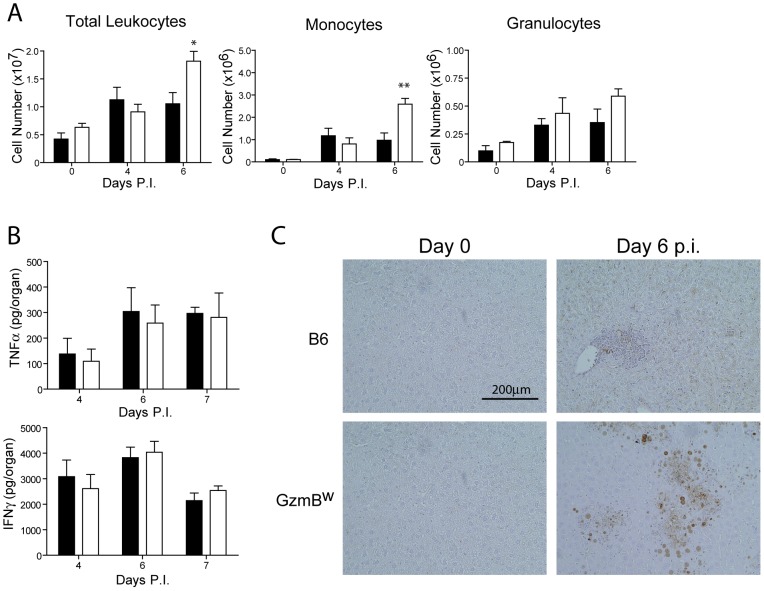
Liver damage in GzmBW/W mice is not the result of immune-mediated pathology.(A) B6 mice (black bar) or GzmBW/W mice (white bar) were infected with Δm157 MCMV and total liver leukocytes, inflammatory monocytes, and granulocytes enumerated at the indicated times. Data are pooled from 2 independent experiments, mean ± SEM are plotted, where n≥5. *P<0.05. **P<0.01. (B) Levels of TNF-α and IFN-γ in the liver at the indicated times post-infection were quantified by ELISA. (C) Livers from uninfected or MCMV-infected mice at day 6 post-infection were stained with the Chroma 101 anti-IE1 antibody followed by detection with a DAB substrate. Sections were counterstained with haematoxylin. The results are representative of two independent experiments.